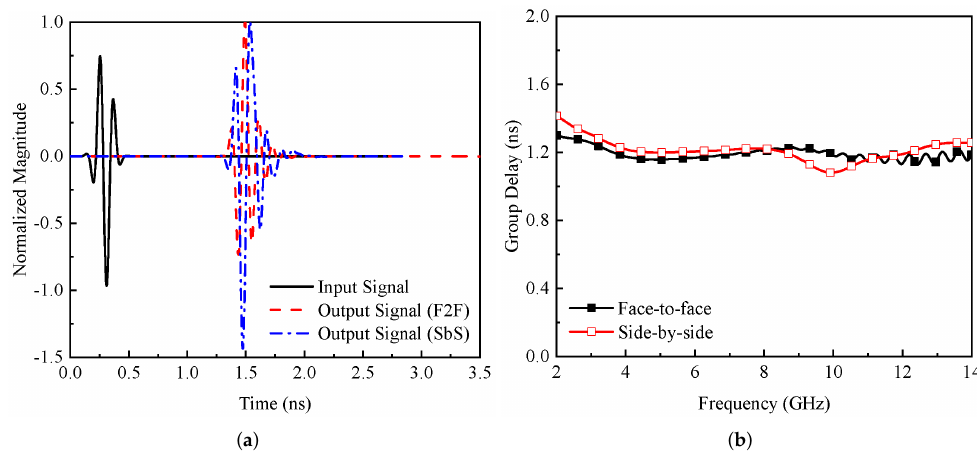
Figure 11. ( a ) Pulse response and ( b ) group delay of the proposed antenna CPW-fed pentagonal fractal